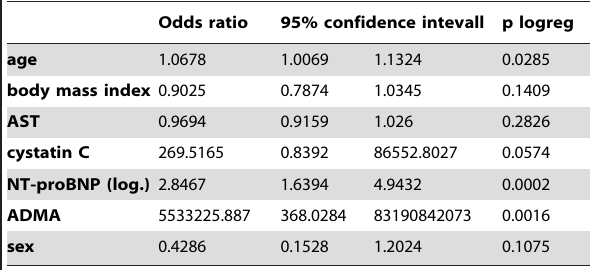
Oxygen pulse in ml/beat 0.48 6 0.10